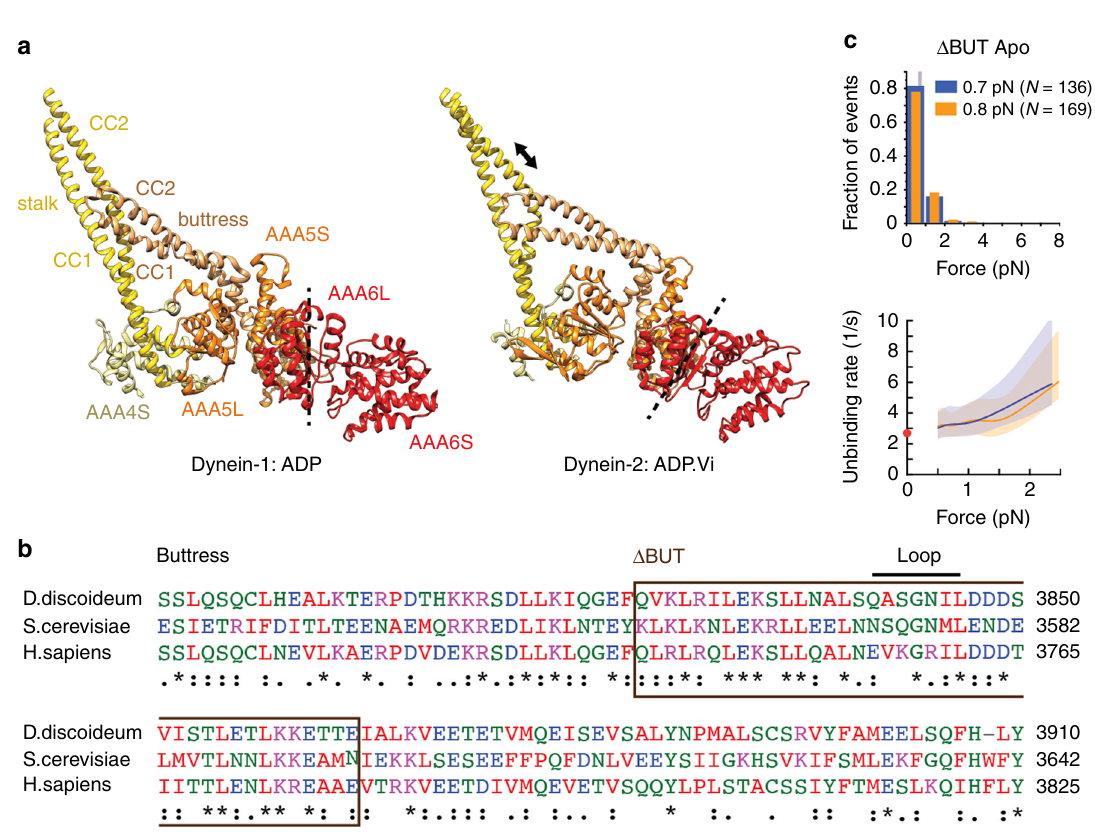
Fig. 5 Tension-induced registry changes of the stalk helices require stalk-buttress interactions. a A comparison of the crystal structures of dynein-ADP (PDB entry 3VKG 14 ) and dynein-ADP.Vi (PDB: 4RH7 47 ) suggests that ATP binding to AAA1 causes a rotation of AAA6L/AAA5S (the dashed line indicates the orientation of AAA6L), resulting in displacement of the buttress (orange) and sliding of CC2 relative to CC1 (arrow), which in turn induces the low- af fi nity MT-bound state 45 . b Alignment of buttress amino acid sequences. Deletion is highlighted. c , top: Normalized histograms of primary forward and backward unbinding forces for the Δ BUT-Dyn1 331kDa mutant (top), with mean values noted (95% CIs [0.6, 0.8] and [0.7, 0.8] pN, estimated by bootstrapping 4,000 samples) (source data are provided as a Source Data fi le). c , bottom: Unbinding rate vs. force derived from the data above. The shaded areas are 95% CIs for the mean rates, estimated by bootstrapping. The depicted zero-load unbinding rate of 2.67 ± 0.05 (characteristic rate ± SEM) (red circle) represents the inverse of the time constant obtained from the analysis of the experimental CDF of the MT-bound lifetimes measured via TIRF microscopy (Supplementary Fig. 2e) (the 95% CIs of the measured unbinding rate (lower limit, 2.58/s; upper limit, 2.77/s) are not shown as they are shorter than the height of the